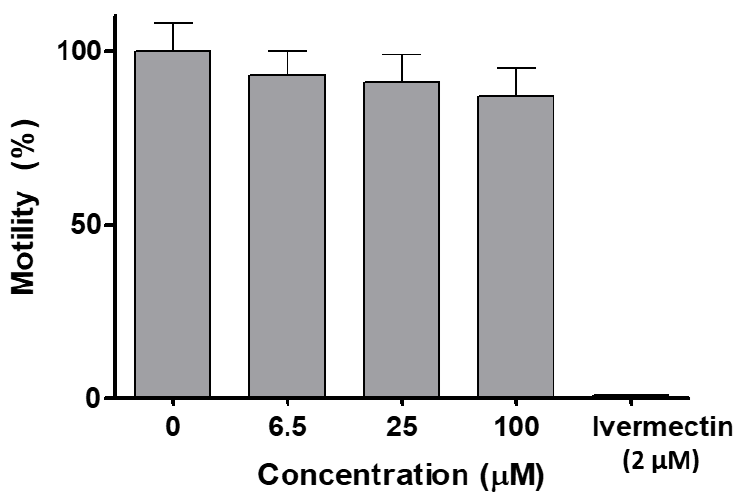
Figure 9. Seventy L4 adult worms were incubated in M9 buffer, 1% DMSO and the vanadium compound at different concentrations (6.25–100 µ M range). Vehicle control (without compound) was used as a reference of normal motility in 1% DMSO. Ivermectin was used as a positive control at 2 µ M. In each experiment, four replicas were performed for each concentration. One experiment of three biological replicates is shown. The experiment was performed twice. Error bars correspond to standard deviations.